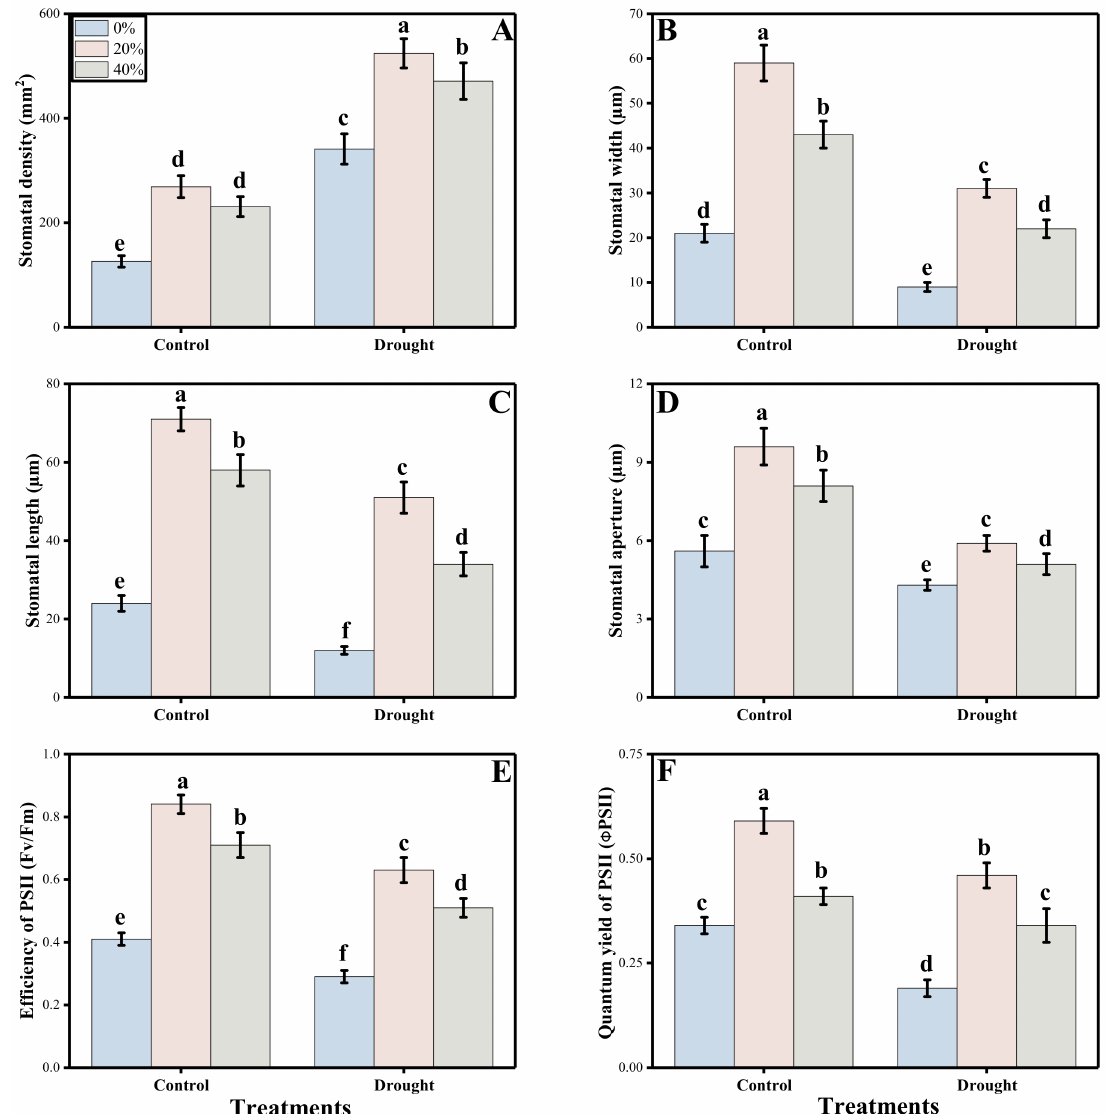
Figure 4. Effect of seed priming with Plantago ovata leaf extract on stomatal density ( A ), stomatal width ( B ), stomatal length ( C ) stomatal aperture ( D ), efficiency of PSII ( E ) and quantum yield of PSII ( F ) under water stressed and non-stressed environments in maize cultivar Cimmyt-Pak. Means sharing similar letter(s) within a column for each parameter do not differ significantly at p < 0.05. Data in the figures are means of three repeats ( n = 3) of just one harvest of Zea mays plants ± standard deviation (SD). Different lowercase letters on the error bars indicate significant difference between the treatments. Different treatments ( P. ovata extract) used in this study are as follows: 0% (0% P. ovata extract), 20% (20% P. ovata extract) and 40% (40% P. ovata